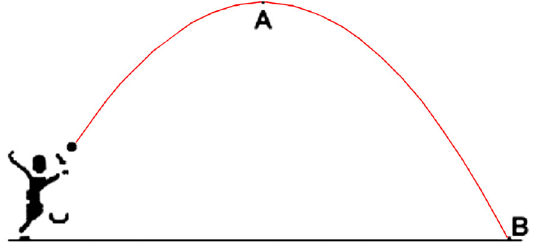
FIG. 4. Question 9 of the 2012 ASOE. This question showed the largest gap in facility in the entire ASOE data